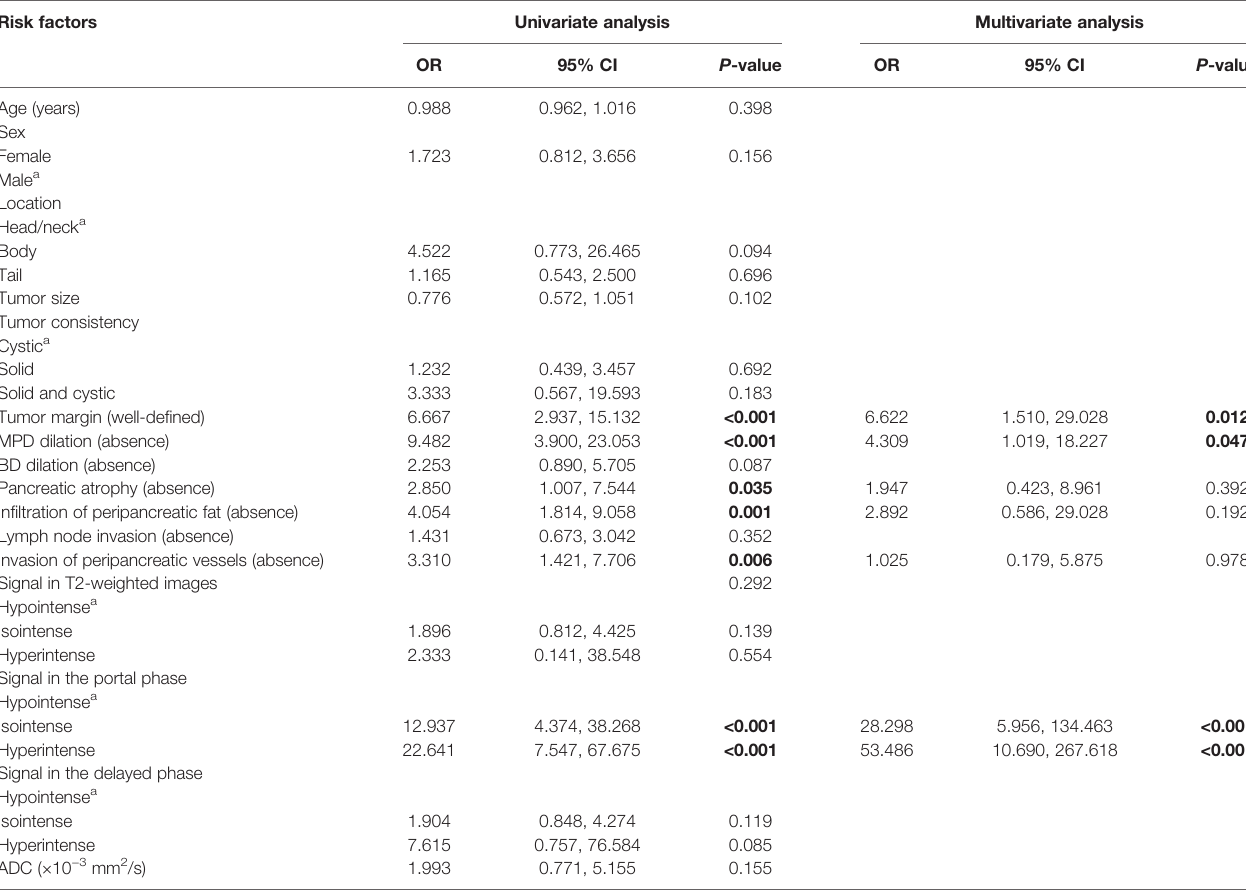
TABLE 3 | Univariate and multivariate analyses for relevant MRI features for differentiating non-hypervascular PNETs and